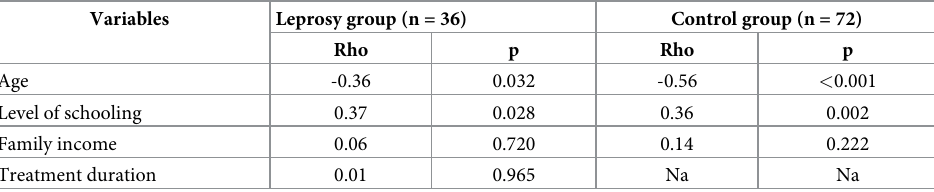
UPSIT: University of Pennsylvania Smell Identification Test , Rho: Spearman´s rho correlation coefficient, Na: not